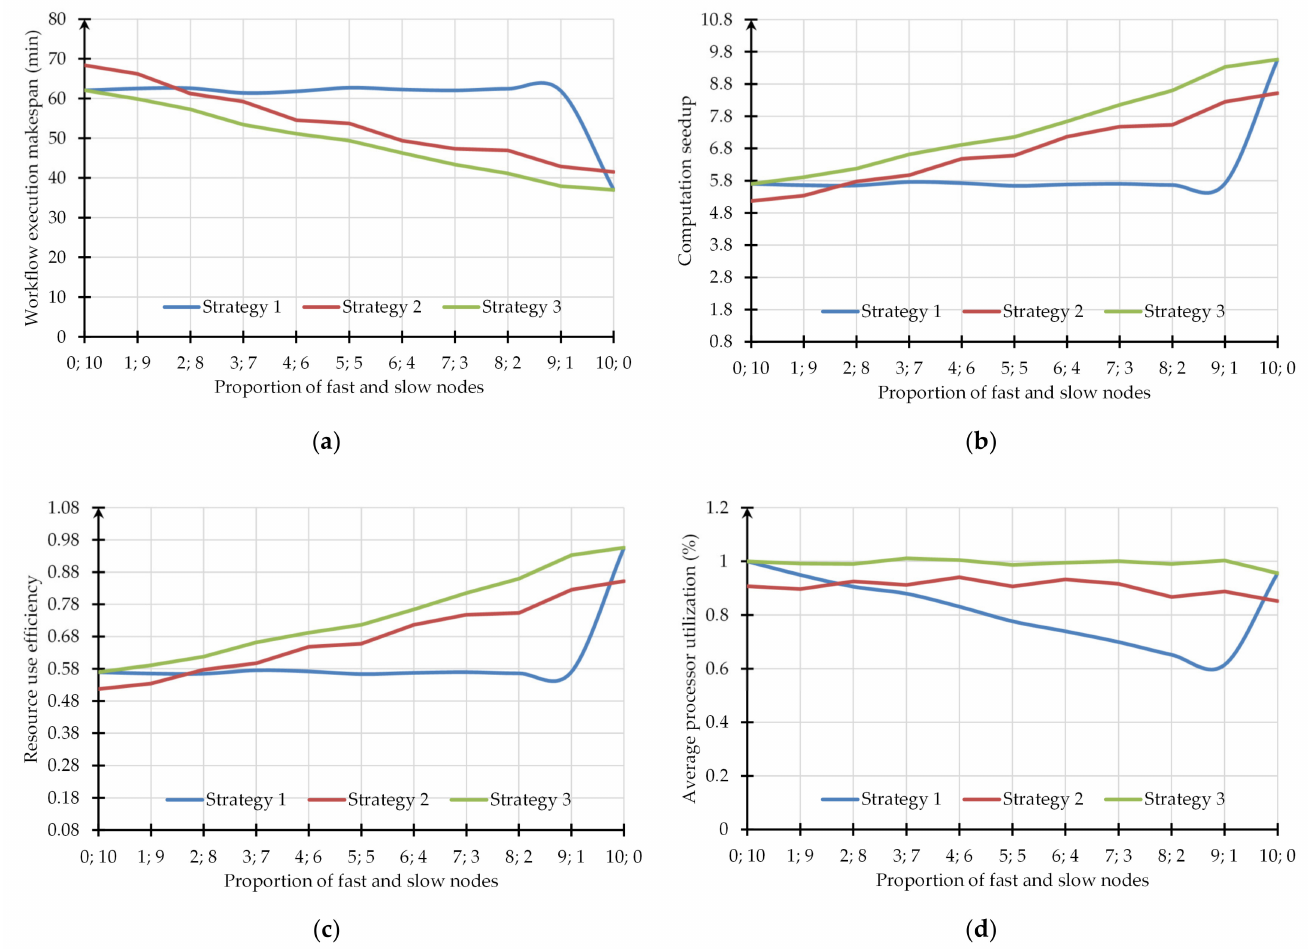
Figure 12. Objectives for three strategies: workflow execution makespan ( a ), computation speedup ( b ), resource use efficiency ( c ), and average CPU utilization ( d ) via different proportions of fast and slow